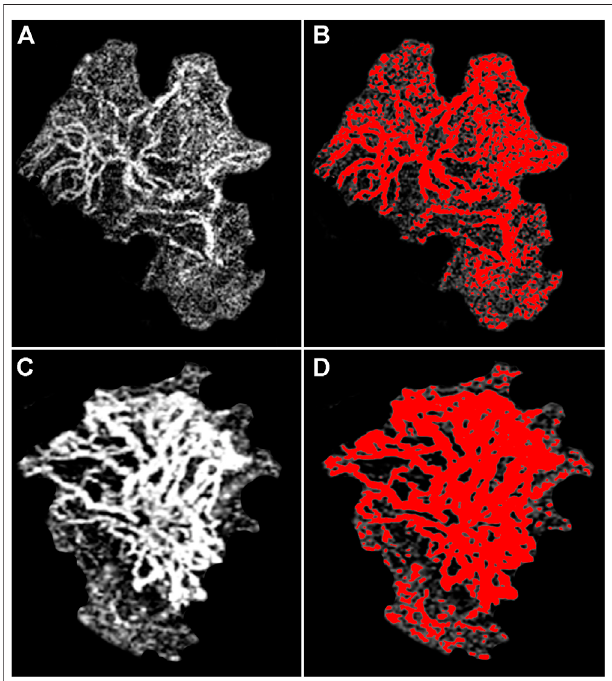
FIGURE 4 | High and low fl ow signal distribution in OCTA MNV reconstruction. Type 1MNV (A) shows ascattered highly detected fl owsignal distribution(red) – withanotableportionoftheMNV,especiallyintheperipheral regions, exhibiting a poorly detected fl ow signal (B) . In contrast, the highly detected fl ow signal (red) is shown tobe more evenly distributed in type 2 MNV (C) , and only a small portion of the entire MNV is characterized by poorly detected fl ow signal (D) .